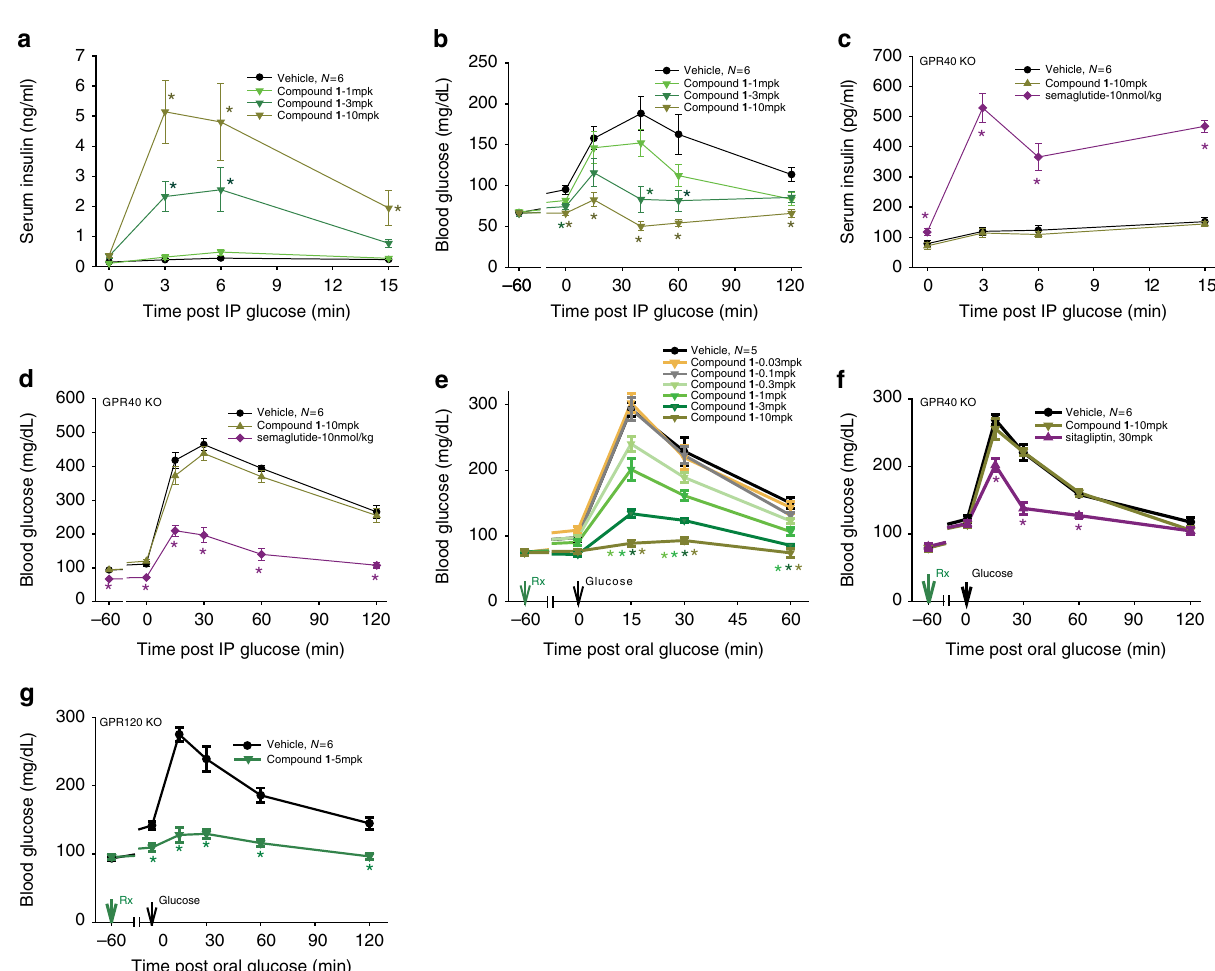
Fig. 2 Glucose tolerance tests in mice. a , b Intraperitoneal glucose tolerance test (IPGTT) in wild type ICR mice. Dose-dependent increases in insulin secretion ( a ) and decreases in glucose excursion ( b ) are seen after treatment with various doses of compound 1 . c , d IPGTT in GPR40 knock-out (KO) mice. Insulin secretion ( c ) and glucose lowering ( d ) are not observed with high dose of compound 1 , but can be triggered with semaglutide treatment. e Oral glucose tolerance test (OGTT) in wild type C57BL/6 mice. Dose dependent decreases in glucose excursion are seen after treatment with various doses of compound 1 . f OGTT in GPR40 KO mice. The KO mice respond to glucose lowering by sitagliptin. No change in blood glucose is seen after treatment with high dose of compound 1 . g OGTT in GPR120 KO mice. A signi fi cant decrease in glucose excursion is seen after treatment with compound 1 at 5 mg/kg. * p < 0.05 vs vehicle by ANOVA with repeated measures followed by Dunnett ’ s